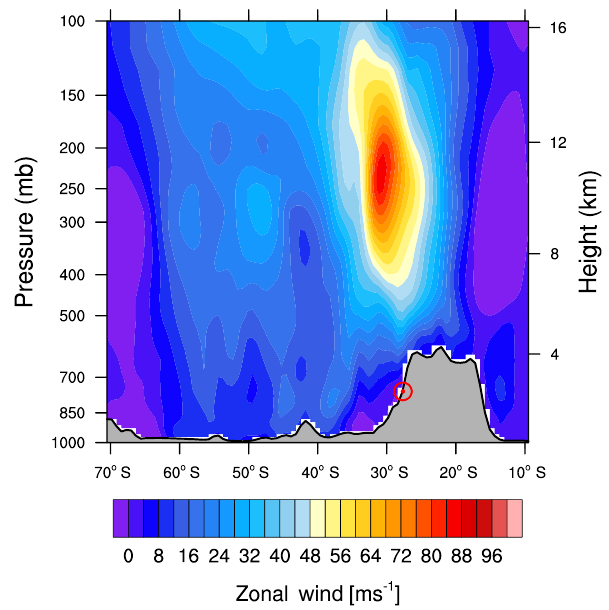
Figure 5. Meridional cross section of zonal wind along the Fi- ambalá longitude on 13 June at 18:00UTC. The subtropical jet stream core at 250hPa shifts equatorward, reaching the Fiambalá latitude (stated by a red circle). Dataset from ERA-Interim reanaly-